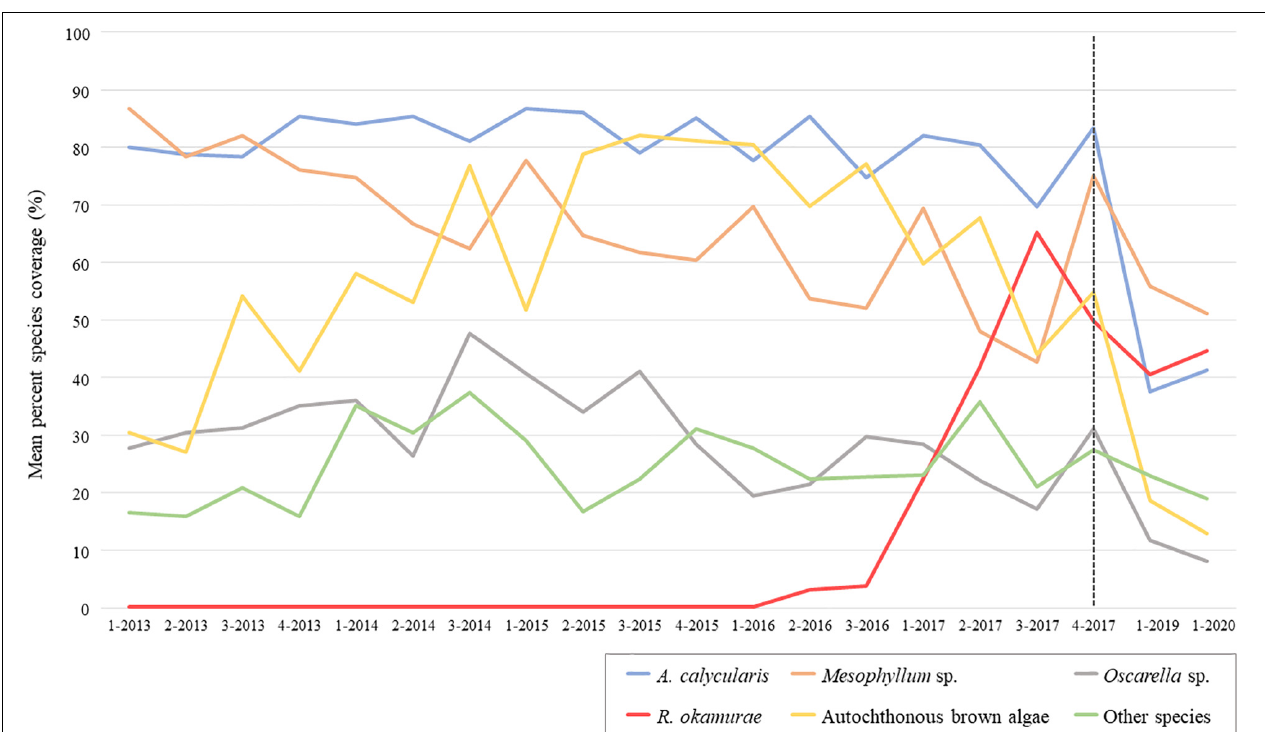
FIGURE 2 | Temporal variation of benthic mean species percent coverage at the SBPQ station in Tarifa Island from years 2013 to 2020 (2018 data is missed). The dotted line locates, at the right side of the graph, the species fluctuations recorded after the last monitoring in 2017. Species with less than 10% coverage ( Alcyonium sp., Aplidium sp., A. armata , Crambe sp., Ircinia sp., and Polycitor adriaticum ) were grouped under “Other species.” 1 = winter; 2 = spring; 3 = summer; 4 =